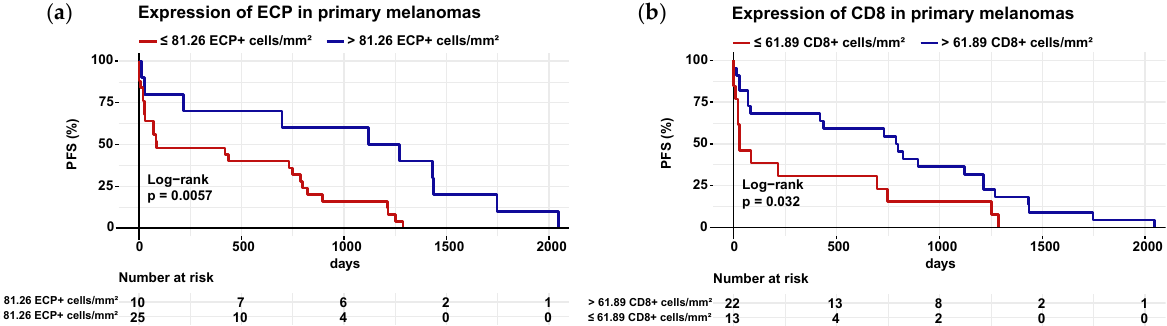
Figure 4. High numbers of ECP expressing eosinophils and CD8 expressing effector T-cells are linked with prolonged PFS in primary melanoma. Kaplan–Meier survival curves for PFS of melanoma patients were stratified by the level (high vs. low infiltration) of ECP+ eosinophils and CD8+ T-cells in the 108 primary melanoma samples. p -values were calculated by the two-sided log-rank test. ( a ) Survival analysis of melanoma patients with increased (>81.26 cells/mm 2 ) ECP expressing cells in the primaries of melanoma versus those with low ECP expression; ( b ) Survival analysis for PFS of melanoma patients with increased (>61.89 cells/mm 2 ) CD8 expressing cells in the primaries of melanoma versus those with low CD8 expression. Abbreviations: PFS: progression-free survival; ECP: eosinophil cationic protein; CD: cluster of differentiation; p : p